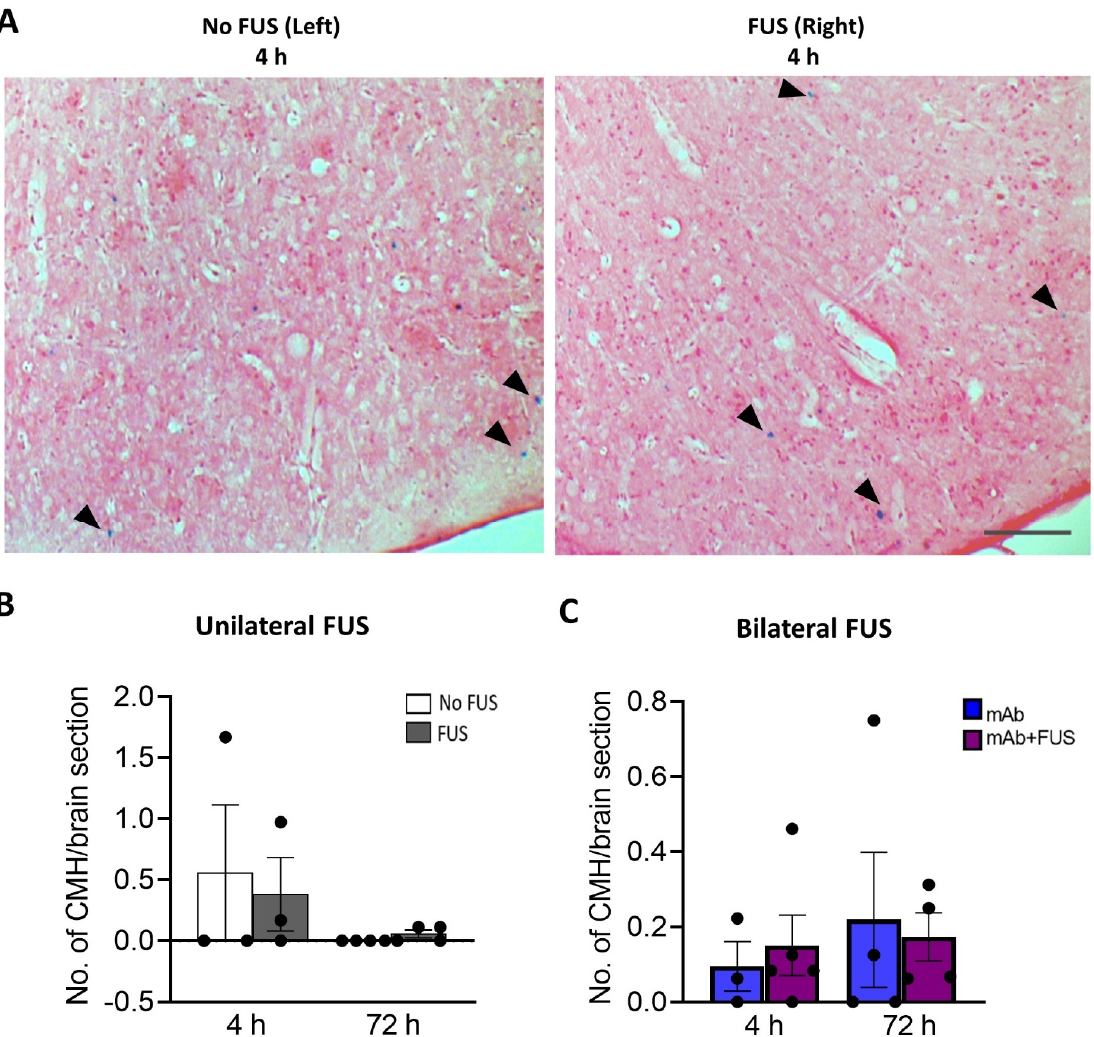
Figure 4. Prussian blue-positive cerebral microhemorrhages (CMH). ( A ) Representative pictures for the Perls’ Prussian blue staining in the cortex after unilateral sonication. Blue colored pigments (ar- rowheads) indicate hemosiderin deposits and these microhemorrhages are observed around capil- laries. ( B) Unilateral FUS cohort with sonication on right hemisphere did not show any significant microhemorrhages compared to the contralateral non sonicated left-hemisphere. Paired t -tests (two- tailed, α = 0.05). ( C ) In the bilateral FUS brain tissue sections no significant CMH were observed